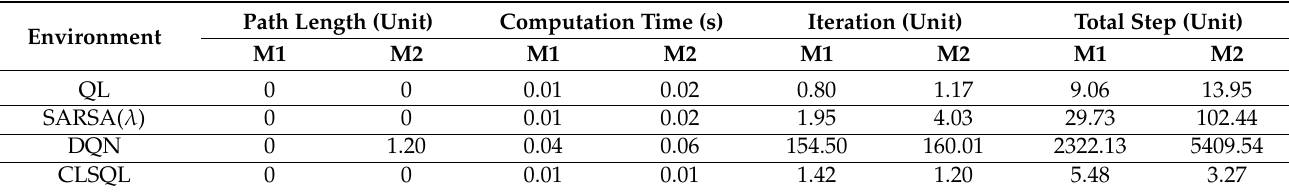
Table 6. Standard Deviation Performance Comparison of Obstacle Maps.